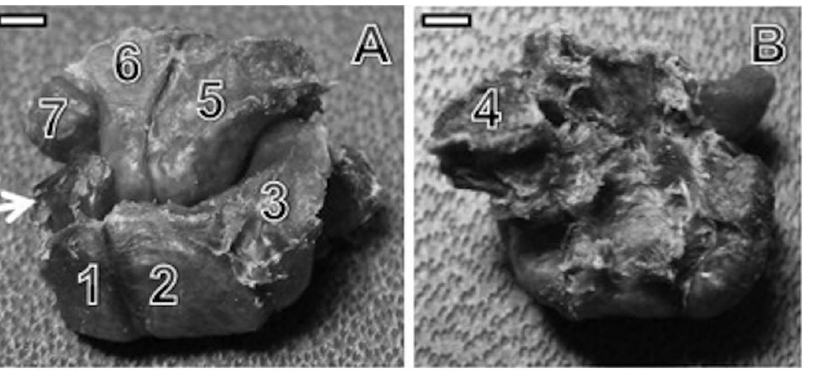
Figure 3. Carpal bones in the right hand of a capuchin monkey. A. Top view of the carpus: (1) scaphoid, (2) lunate, (3) pyramidal, (5) hamate, (6) capitate and (7) trapezoid bones. The arrow indicates the central bone. B. Bottomview of the carpus: (4) pisiform bone. The trapezium bone is not present in this piece (bar=4 cm).